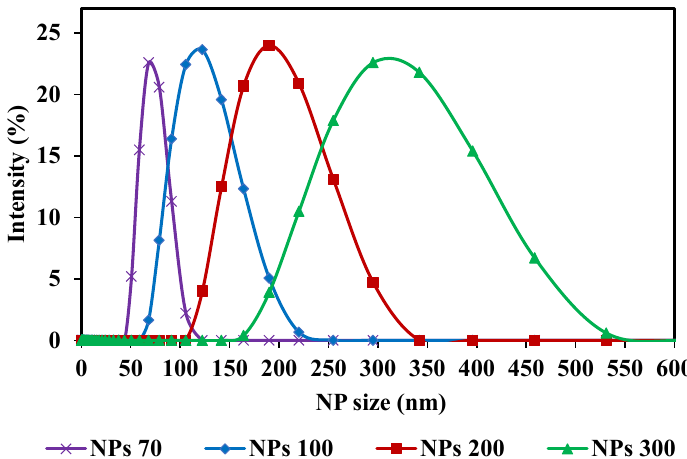
Figure 2. Nanoparticle size distribution curves (NPs) of the initial solutions (feed): NPs 70; 100; 200 and 300 nm, used in the filtrations.